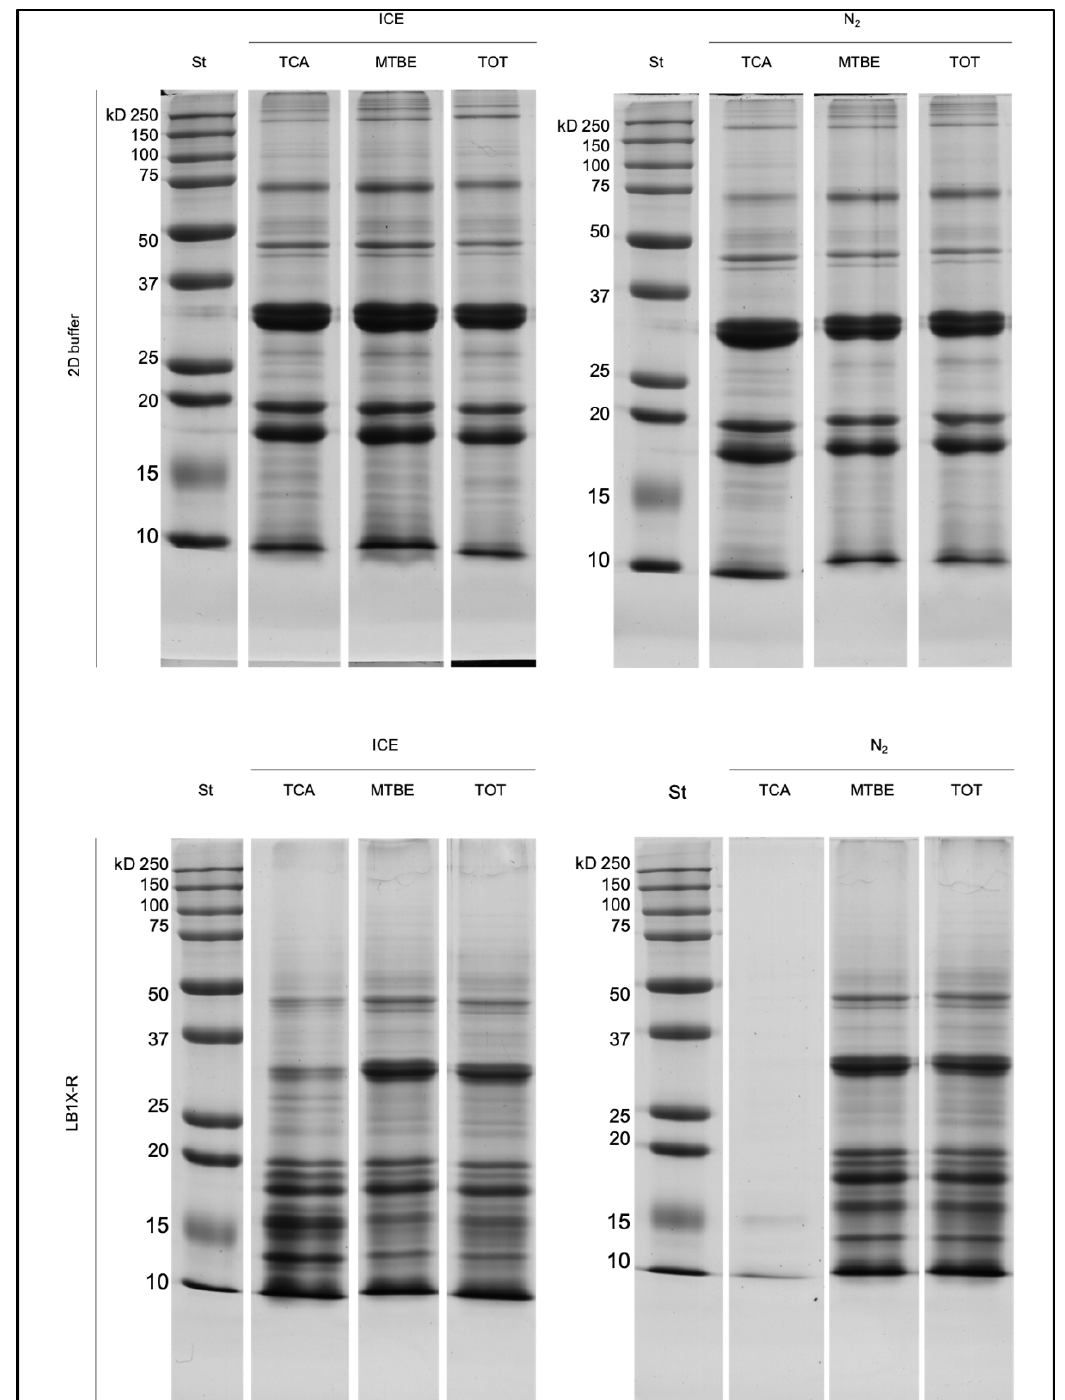
Figure 2. SDS PAGE of ICE + 2D buffer extracts and N 2 + 2D buffer extracts, ICE + LB1X-R buffer extracts and N 2 + LB1X-R buffer extracts. Three different methods are compared: TCA/Acetone precipitation (TCA), MTBE:MeOH delipidation (MTBE), hexane delipidation (TOT).